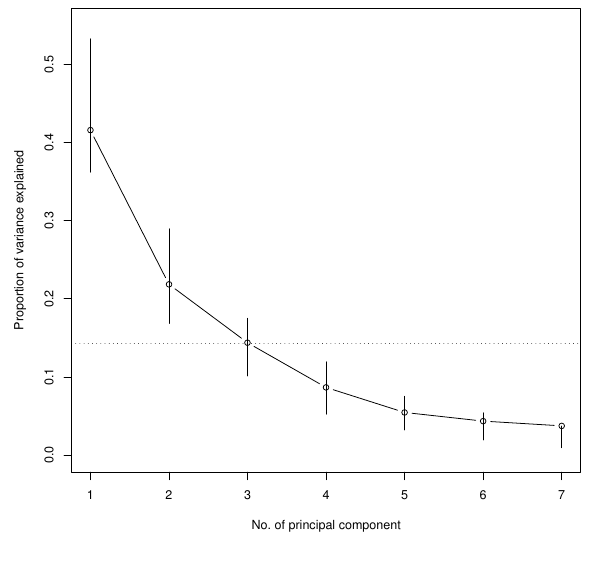
Figure 1 Scree plot showing the proportion of variance explained by consecutive principal components (PCs) . Bootstrapped 95% confidence intervals are shown as vertical lines. The dotted horizontal reference line indicates the proportion of variance explained by one of the underly- ing variables (i.e. category